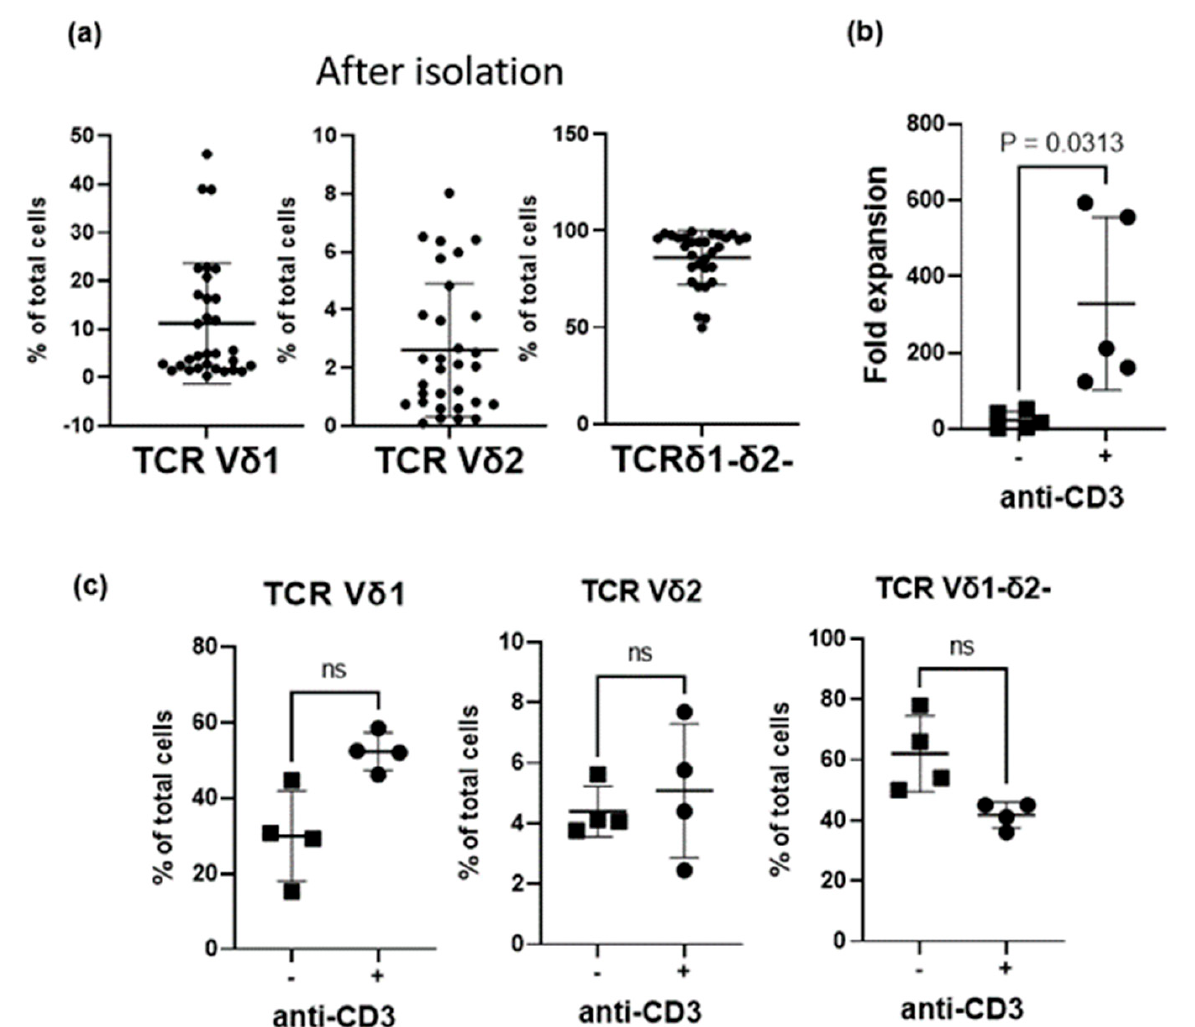
Figure 1. Effects of aAPCs with anti-CD3 antibody on proliferation of γδ T cells negatively isolated from cord blood. ( a ) Distribution of V δ 1, V δ 2, and V δ 1-V δ 2- γδ T cells after negative isolation with magnetic beads from cord blood samples ( n = 31). ( b ) Increased γδ T-cell proliferation as shown with an anti-CD3 antibody ( n = 5). ( c ) Distribution of V δ 1+, V δ 2+, and V δ 1-V δ 2- γδ T cells according to the presence or absence of anti-CD3 antibody in culture for two weeks ( n = 4). Data shown in ( b , c ) are the mean ± SD of V δ 1+ T cell frequencies from 4 independent cord blood donors. P values were calculated using Wilcoxon matched-pairs signed rank test. ns: not significant, aAPCs: artificial anti- gen presenting cells.